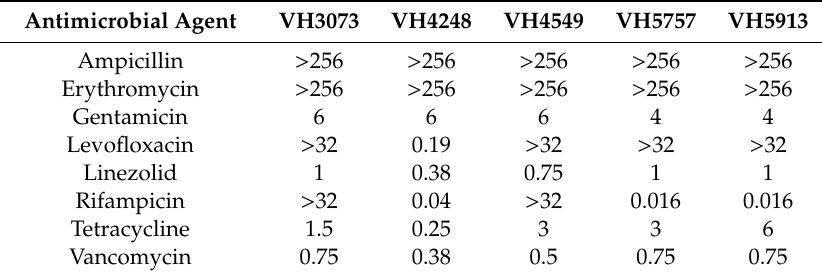
Table 2. MIC values of five C. urealyticum whose genomes were sequenced. MICs are expressed in mg / L. Antimicrobial Agent